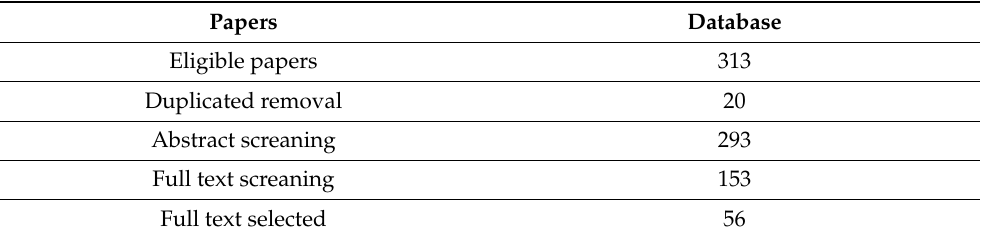
Table 1. Papers selection